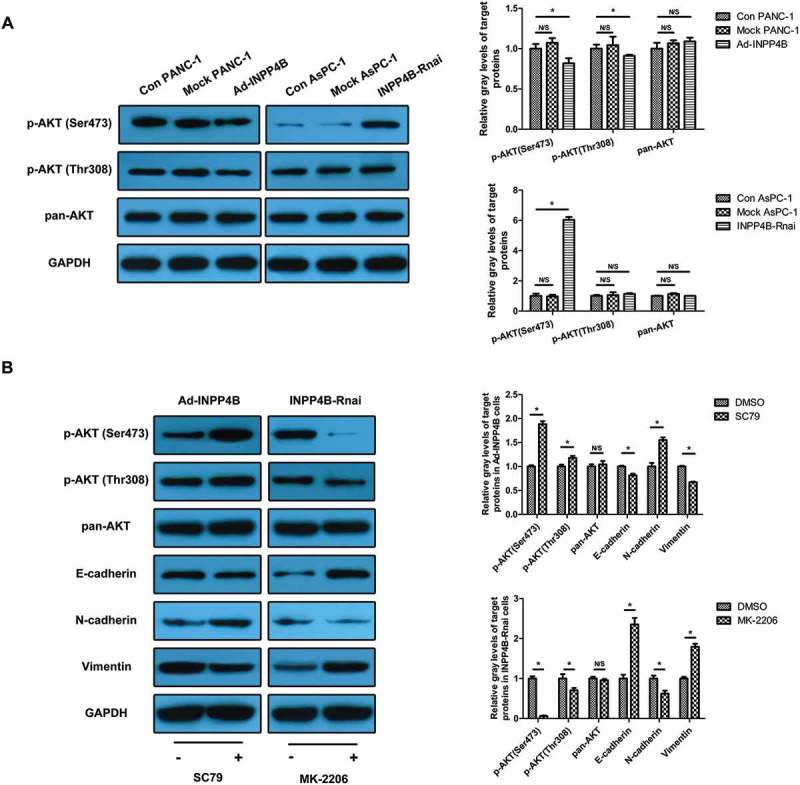
The involvement of AKT in INPP4B-mediated EMT marker turnover (a) Western blot analysis of transduced cell lysates showed INPP4B mainly inhibited AKT activation at Ser473 residue compared to control ones. (b) SC79 treatment on Ad-INPP4B infected PANC-1 led to a significant increase in p-AKT at Ser473 and Thr308 compared to DMSO-treated cells, which contributed to the impairment of INPP4B function on EMT marker turnover. MK-2206 treatment in INPP4B-siRNA transfected AsPC-1 simulated the effect of INPP4B on p-AKT (Ser473) and compensated for the adverse impact of INPP4B loss on cadherin and Vim expression compared to DMSO-treated cells. The results of western blot were analyzed basing on gray-level ratio of target band. GAPDH was used as housekeeping gene for data normalization. Results show mean ± SD (n = 3). N/S and * indicate P> 0.05 and P < 0.05.